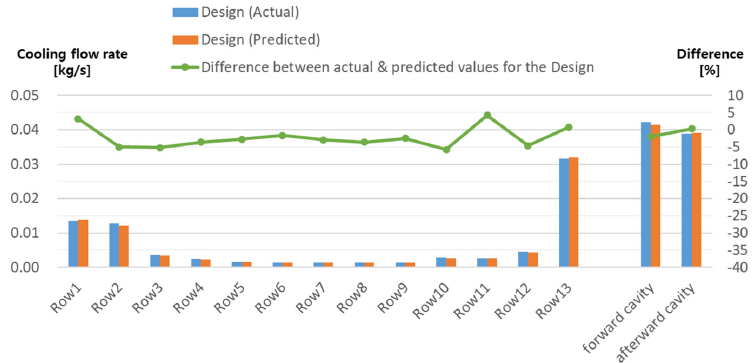
Figure 12. Temperature distribution and streamline around the leading edge (adapted with permis- sion from [16]; copyright 2021 Korean Society for Fluid Machinery).